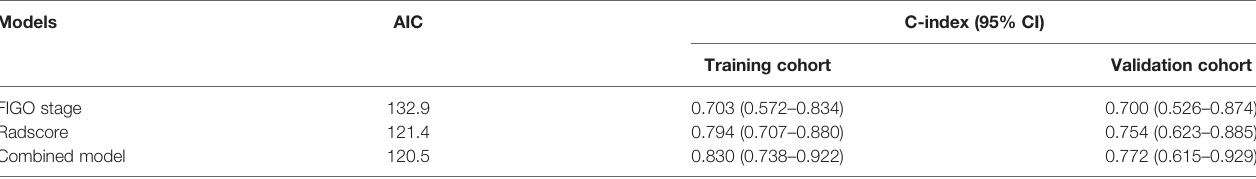
FIGO, International Federation of Gynecology and Obstetrics; AIC, Akaike information criterion; CI, con fi dence interval; OS, overall survival.